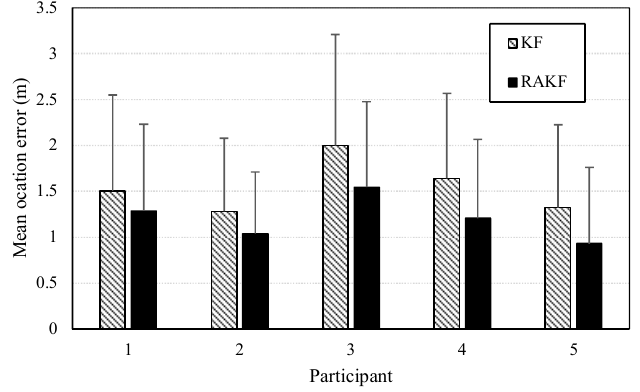
Figure 13. Mean values of location errors in location tracking of KF and RAKF regarding five participants (the error bar stands for the STD. = of location errors).